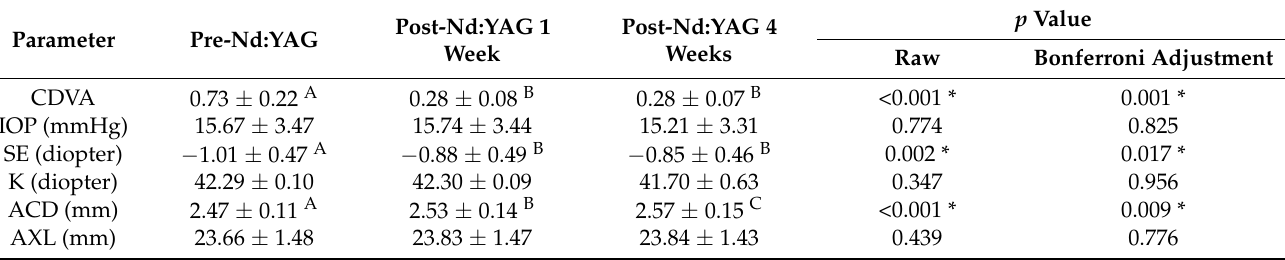
Table 3. The change in parameters in the late Nd:YAG